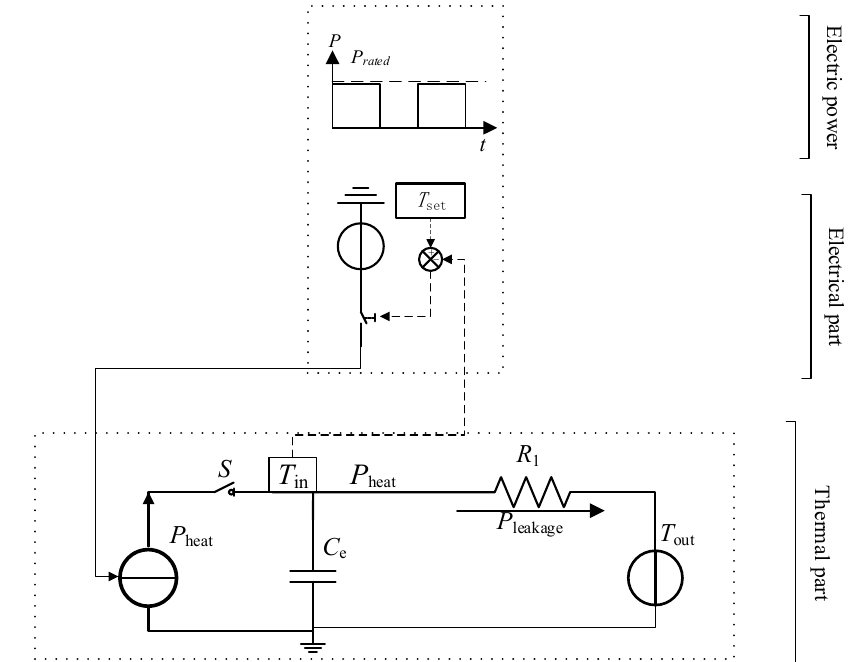
Figure 4. VES model of electric water heater.